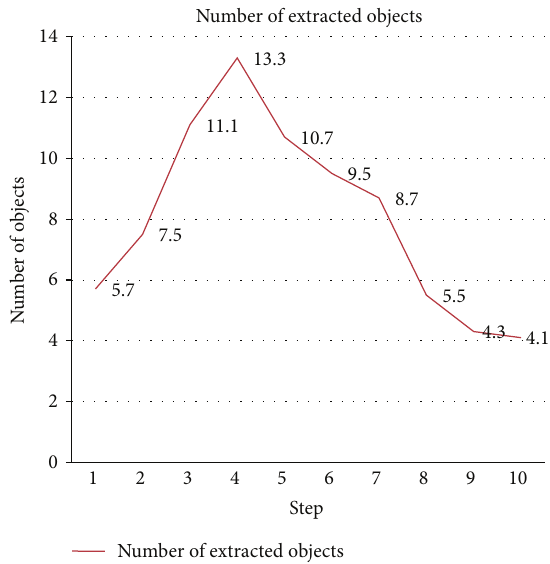
Figure 3: Number of well-extracted objects for segmentation steps.